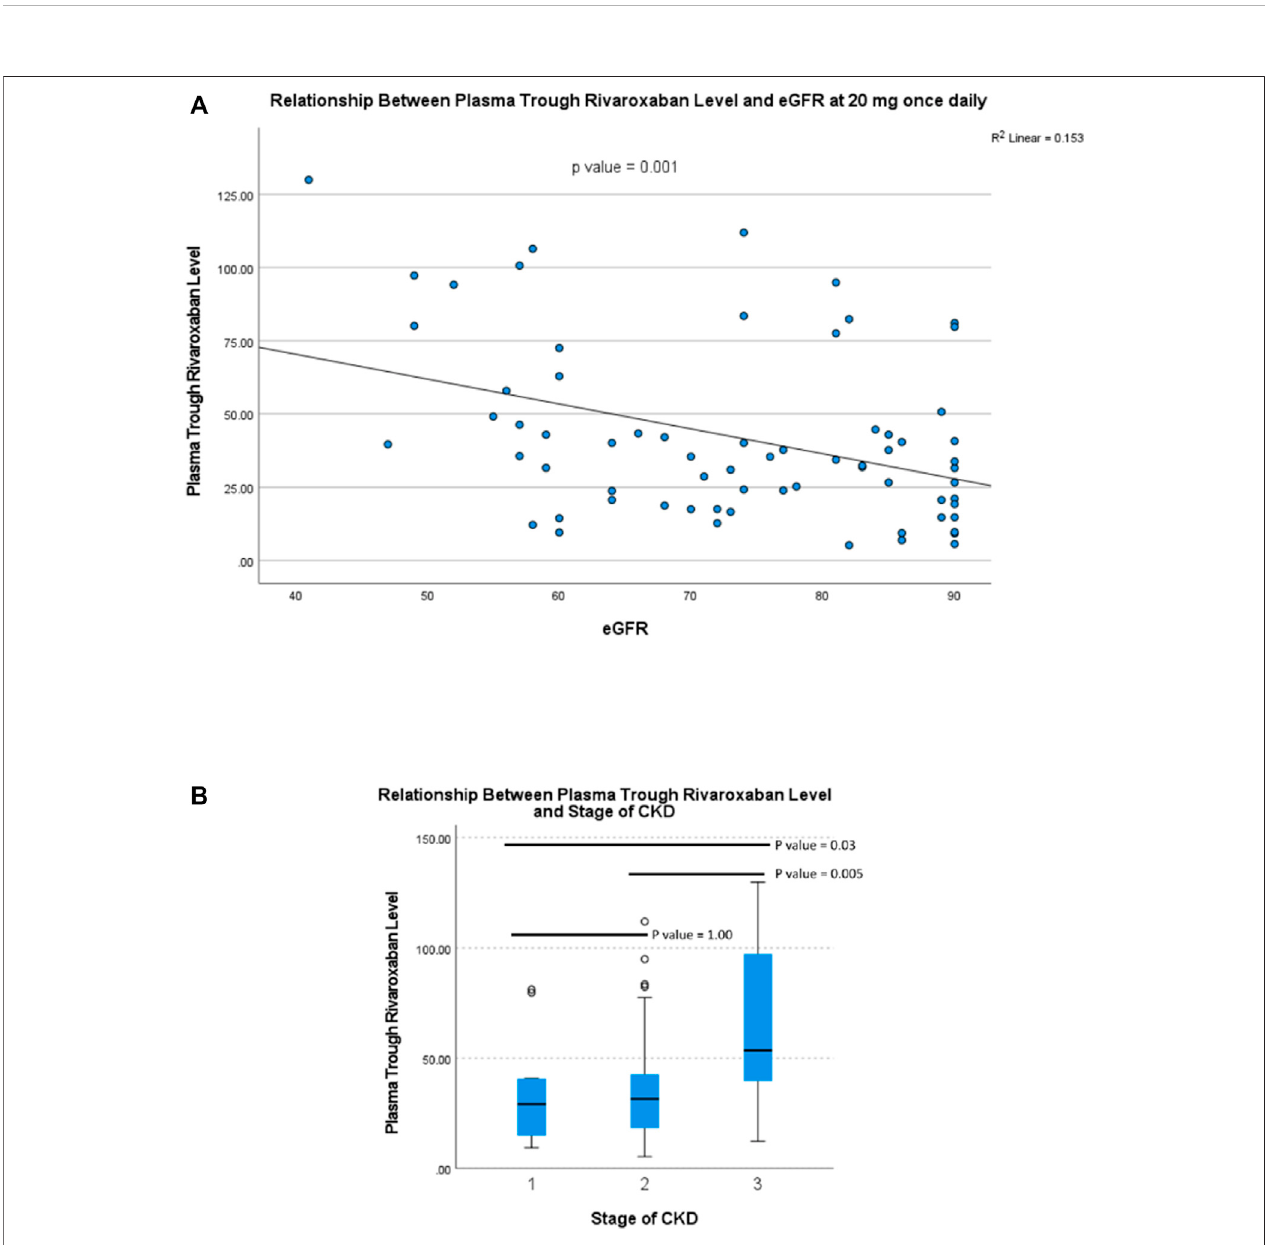
FIGURE 1 | Relationship between plasma trough rivaroxaban level and (A) eGFR and (B) stage of CKD in patients receiving rivaroxaban 20 mg once daily.